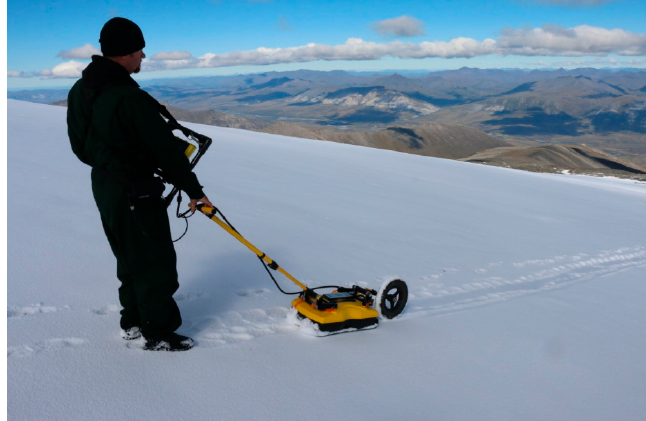
Figure 17. T. Urban collecting GPR data on ice patch. Photo by J. Rasic 2016.